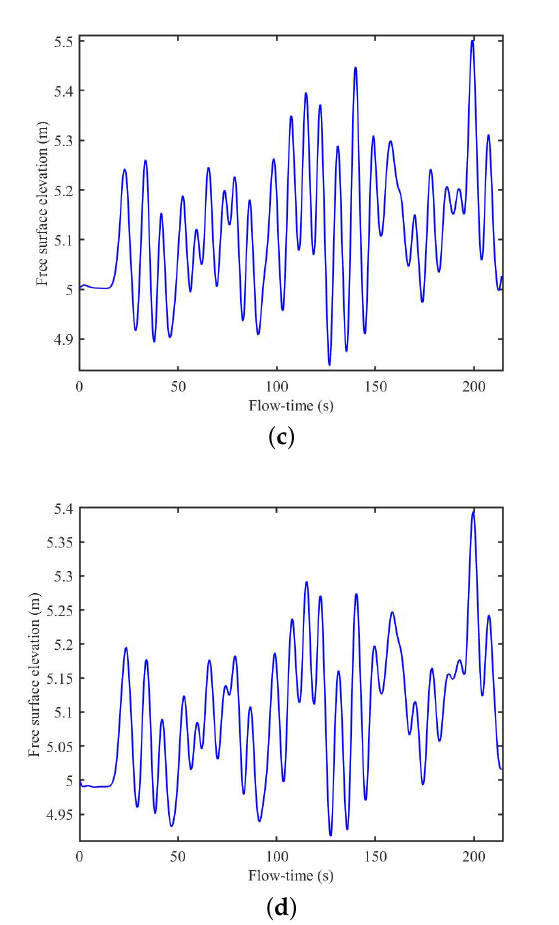
Figure 14. Variation in the free surface at different locations: ( a ) x = 0.5 m, ( b ) x = 72.025 m, ( c ) x = 143.5 m and ( d ) x = 146.4 m, with H s = 1.23 m and ω p = 0.811 Hz.